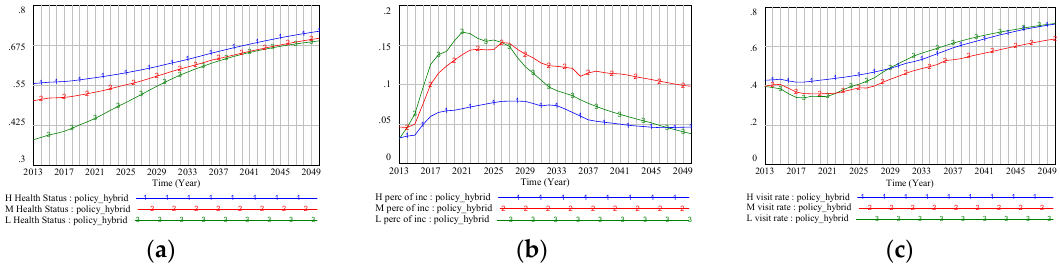
( c ) Figure 8. ( a ) Medical costs as a proportion of income (Policy Scenario 2); ( b ) doctor-visiting rate (Policy Scenario 2); ( c ) health gap (Policy Scenario 2). Note: BAU scenario: SES–health disparity scenario; FD scenario: SES–FD–health disparity scenario; Policy 1 scenario: scenario with intervention policy of lower drug prices; Policy 2 scenario: scenario with intervention policy of higher income promotion for the low-SES group; Policy hybrid scenario: scenario with two intervention policies. 3.3. Policy Conparison To further understand the comprehensive intervention effect of the FD policy and supporting policies on health disparity, three policies (the FD policy, lower medical prices, and a higher income level for the low-SES group) were introduced simultaneously in the model. On the whole, the results indicated that the simultaneous implementation of these three policies could greatly improve the level of health for the different SES groups, although health status still remained worse for the low- SES group than for the other two groups. Specifically, health status was projected to rise from 0.378 to 0.685 in the low-SES group, from 0.501 to 0.696 in the middle-SES group, and from 0.554 to 0.715